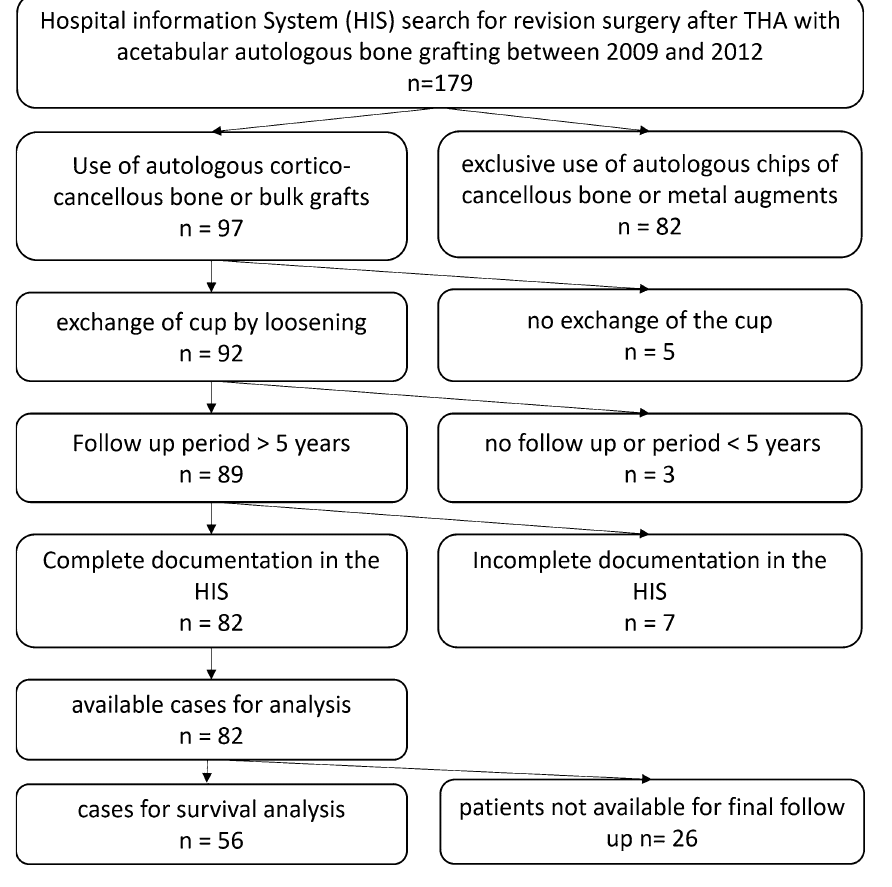
Figure 1. Flowchart of case inclusion and